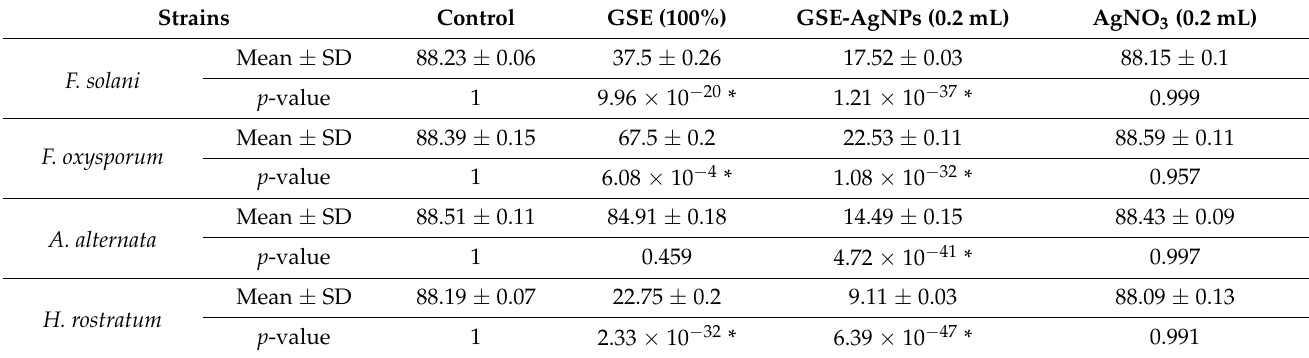
Table 4. GSE and biosynthesized nanoparticles affect the mycelial growth (mm) of the studied fungi. Strains